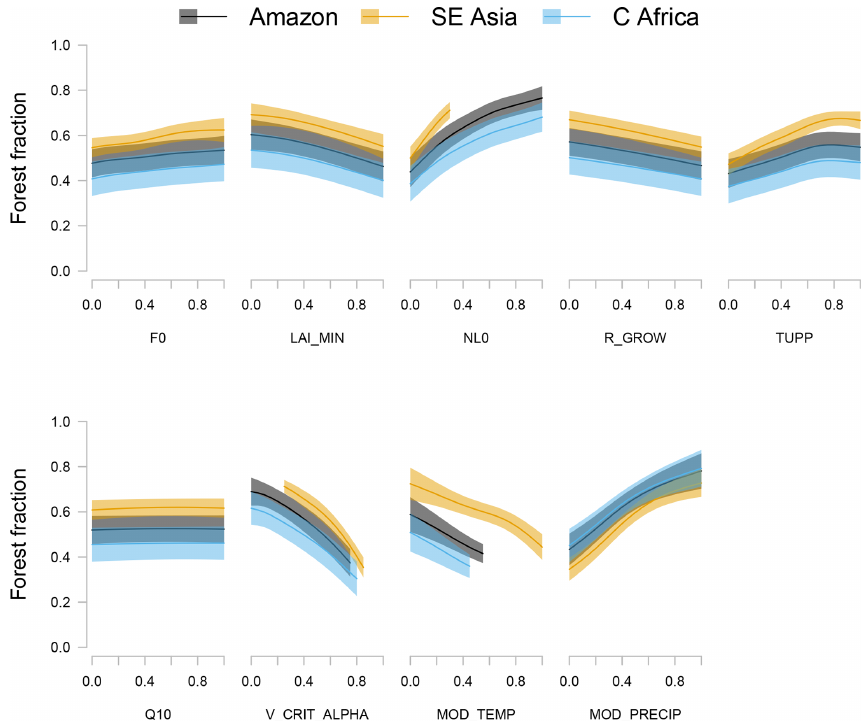
Figure 14. One-at-a-time sensitivity of forest fraction variation of each parameter and climate variable in turn across the NROY parameter range. All other parameters or variables are held at their default values while each parameter is varied, and values of model broadleaf forest fraction which are statistically far from observations are excluded. Solid lines represent the emulator mean and shaded areas represent ± 2 standard deviations of emulator